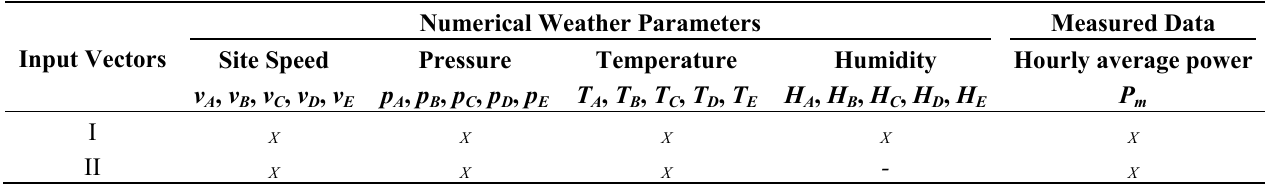
Table 1. Numerical weather parameters included in the input vectors.